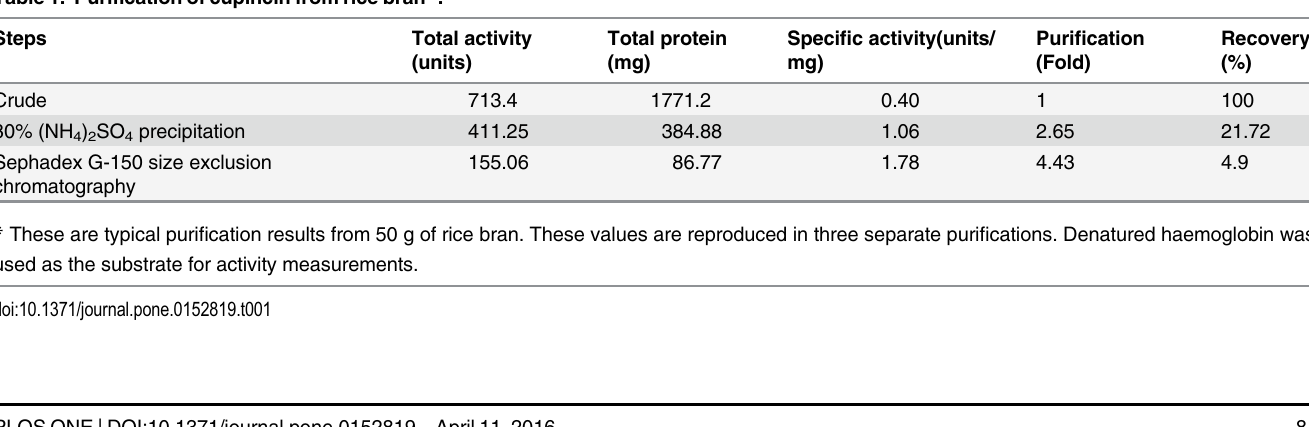
Table 1. Purification of cupincin from rice bran *